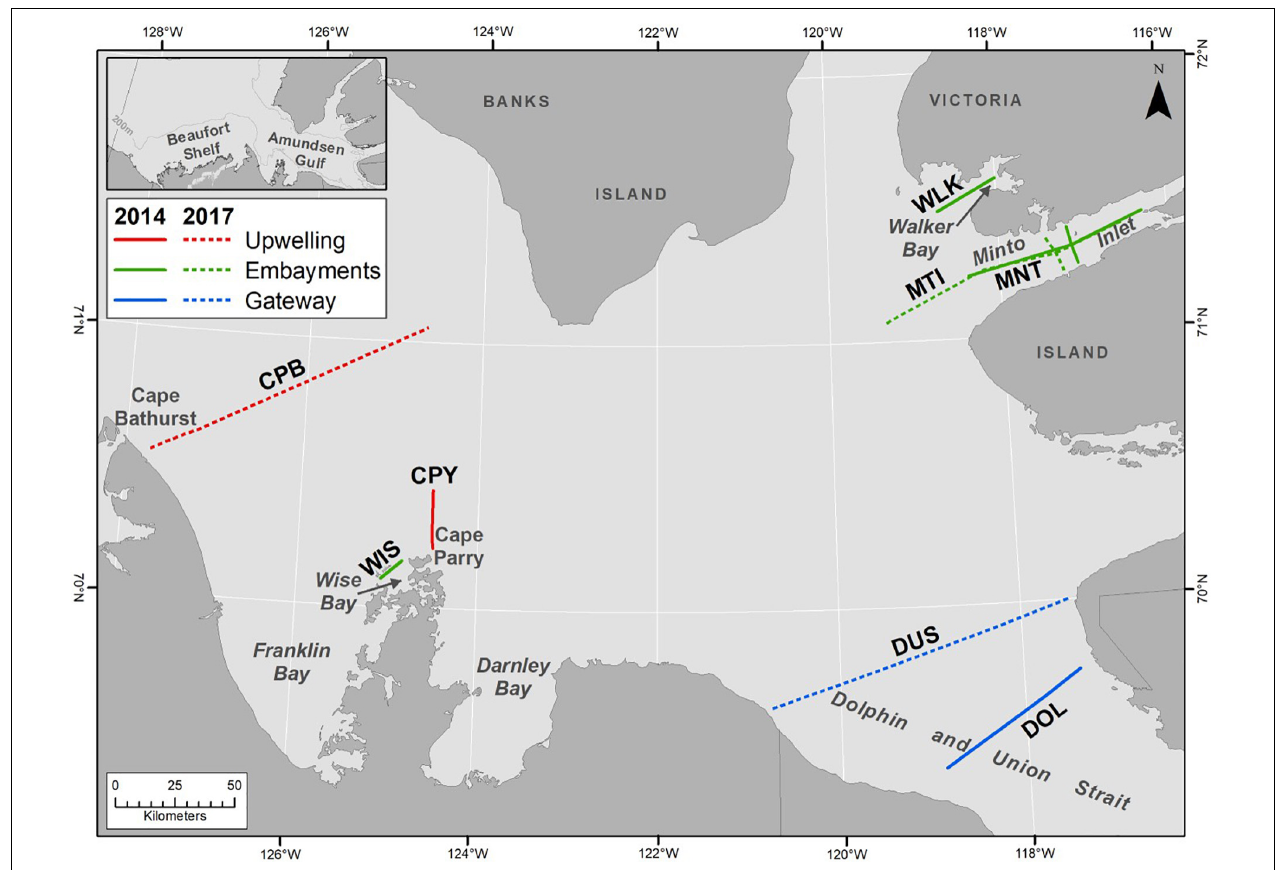
FIGURE 1 | Upwelling, embayment and gateway transects sampled in 2014 and 2017 to assess pteropod shell dissolution in the Amundsen